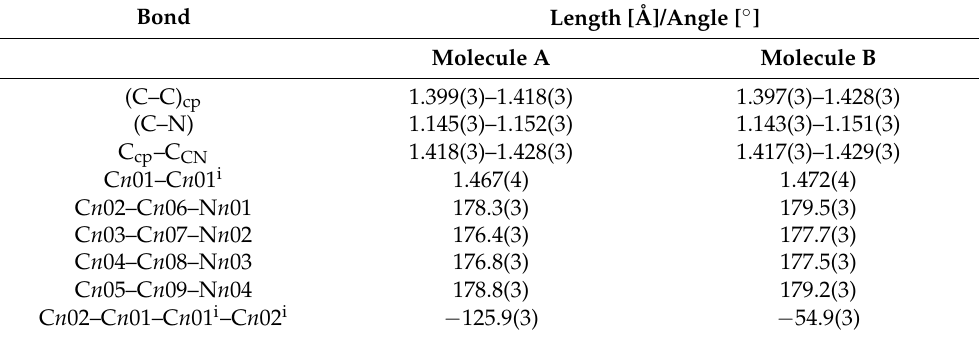
Figure 10. The complete octacyanofulvalenediide dianion of molecule A of compound 5 . Table 3. Bond parameters of compound 5.